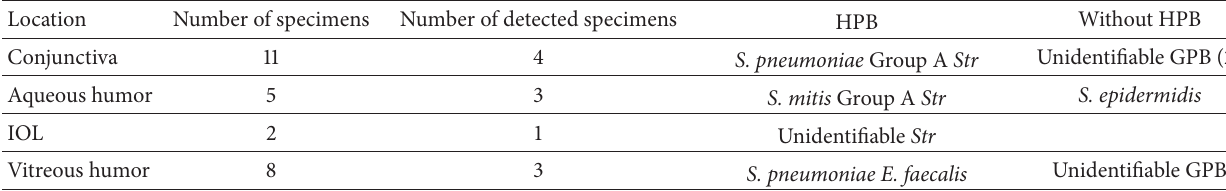
Table 2: All specimens and distribution and details of specimens.